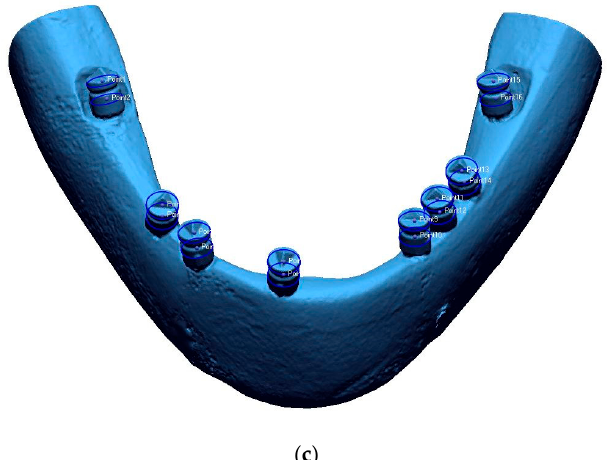
Figure 4. ( a ) First circle on the scan body, ( b ) Second circle on the scan body, ( c ) The centers of the two cross-section circles of all scan bodies